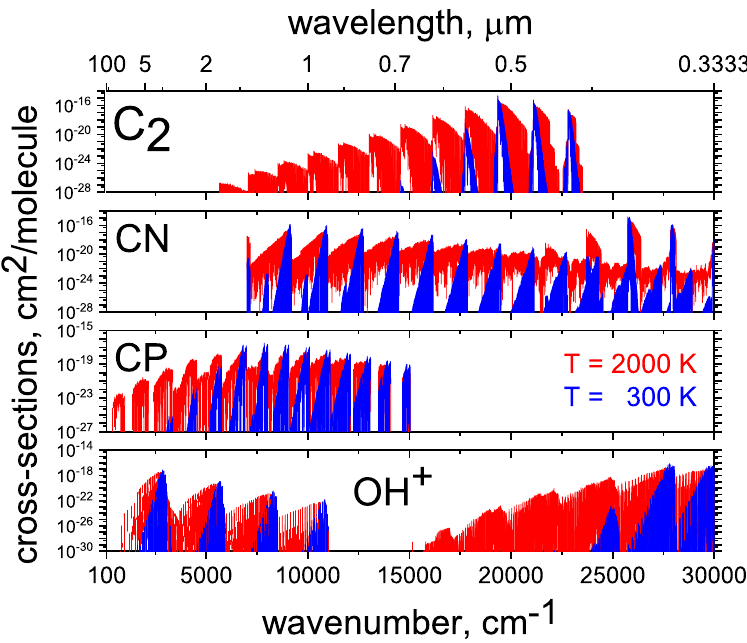
Figure 4. Absorption cross sections of C 2 [45], CN [47], CP [46] and OH +